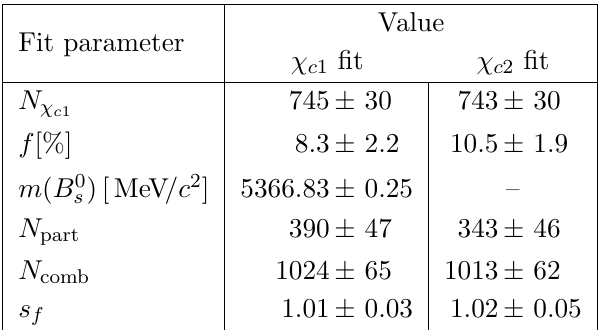
Table 1 . Results of the (cid:31) Gaussian constraint is applied to the s f